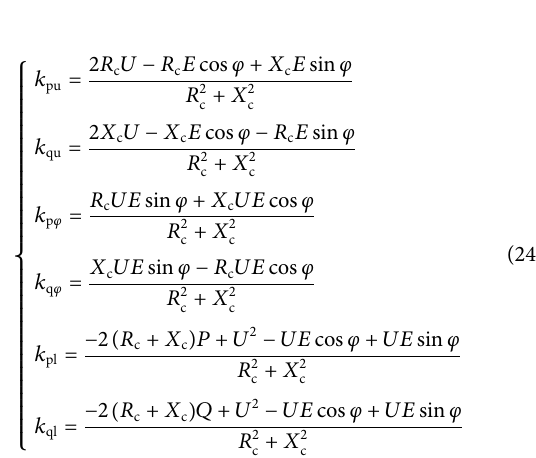
FIGURE 8 Simulation model of islanded microgrid.